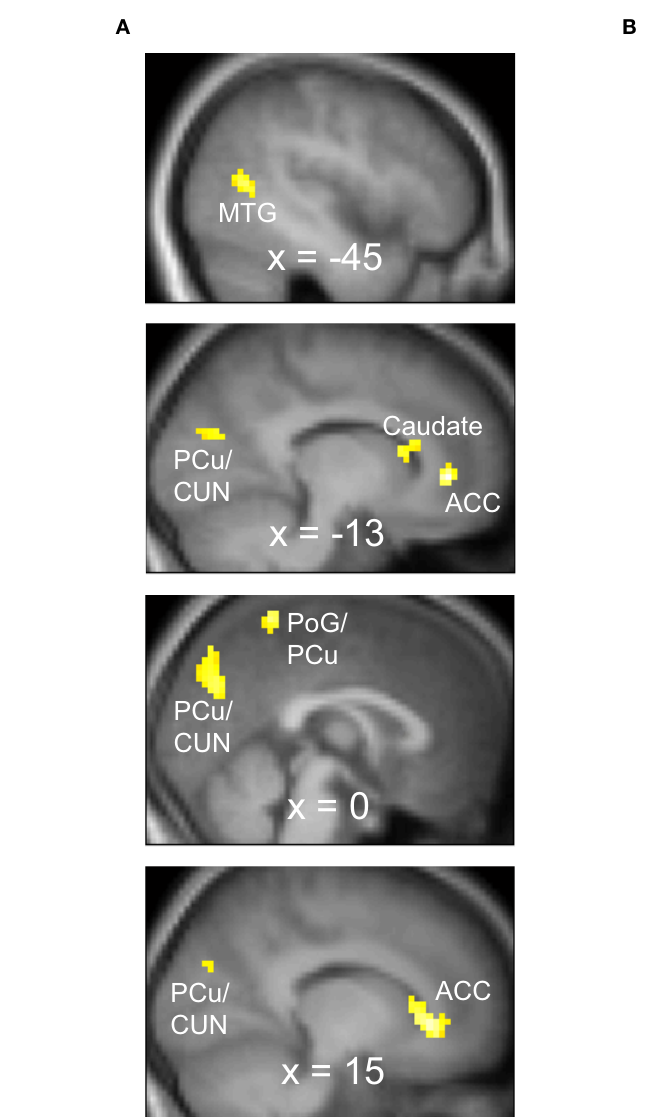
FIGURE 3 | Brain areas demonstrating a differential association between gaze duration spider – bird and BOLD activation spider – bird in spider phobics vs. controls. (A) Significant clusters in whole-brain analysis; negative association in phobics; positive association in controls. (B) Illustration of the